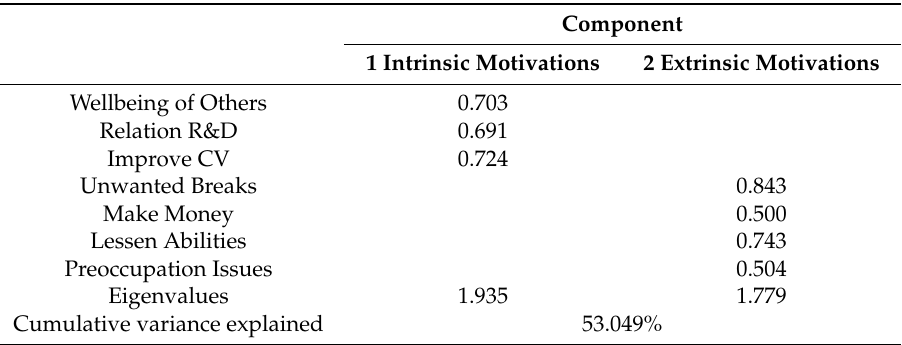
Table 6. Rotated matrix of